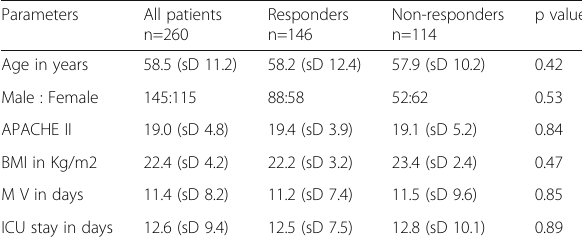
Table 11 (abstract A11). Baseline characteristics